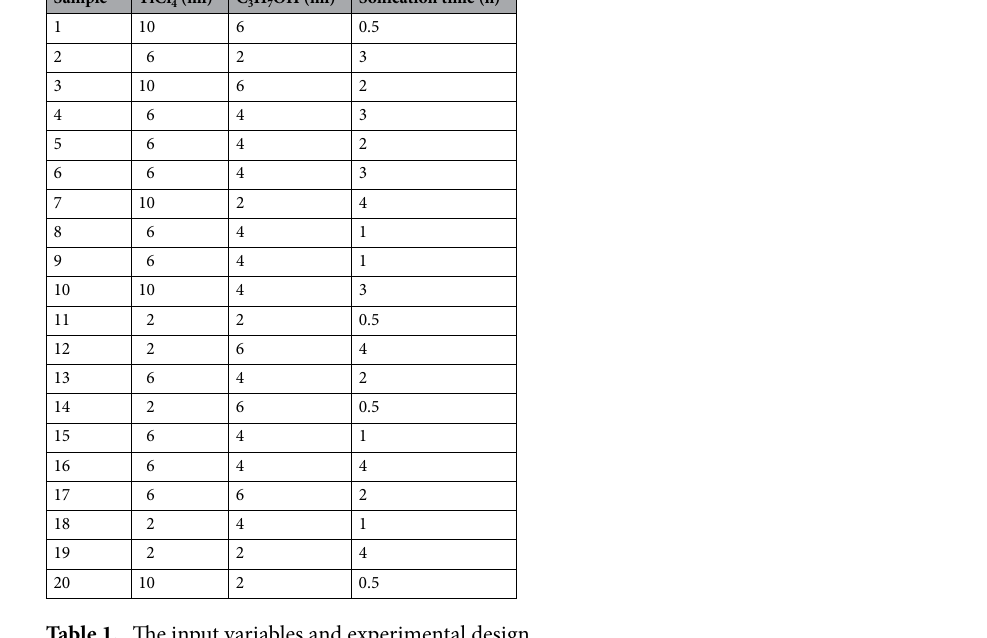
Table 1. The input variables and experimental